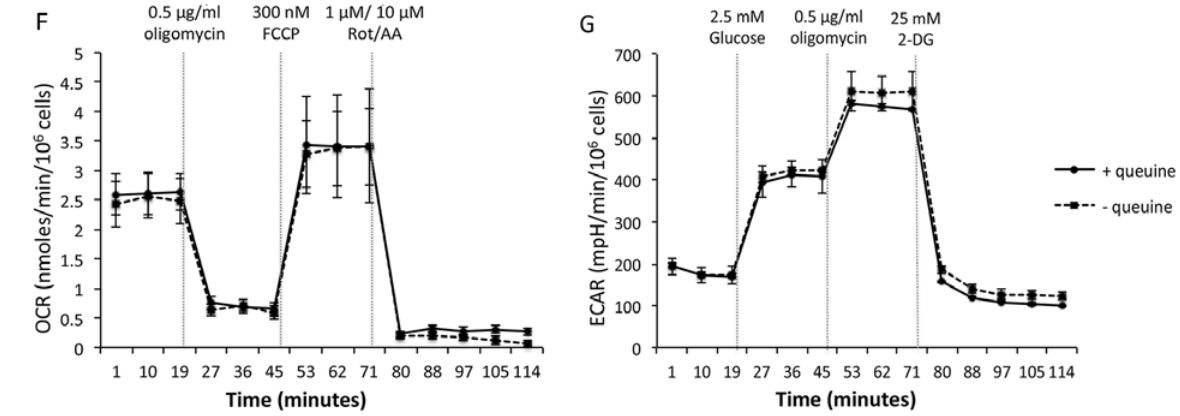
Figure 5. Proliferation and metabolism of queuine deficient human breast adenocarcinoma cell line, MDA-MB-231. ( A ) Growth of MDA-MB-231 cells in Leibovitz L15 medium (10% FBS) is indistinguishable from that in serum-free, growth factor-free medium (SGF medium). ( B ) Cells passaged every three days (P1, P2, etc .) on 96-well plates subject to FluoReporter ® Blue Quantitation assay. Data are means ± SD ( n = 8). ( C ) Incorporation of [ 3 H]-queuine into MDA-MB-231 tRNA (acid-precipitable fraction) increases with concentration. Data are means ± SD ( n = 4). ( D ) Incorporation of [ 3 H]-queuine into MDA-MB-231 tRNA (acid-precipitable fraction) increases with time. Data are means ± SD ( n = 4). ( E ) Incorporation of [ 3 H] thymidine (0.4 μCi mL −1 ) into MDA-MB-231 DNA is